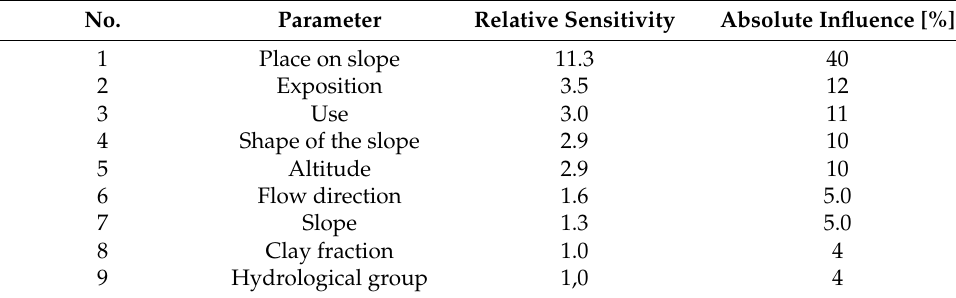
Table 5. Global sensitivity analysis of the MLP 9-4-1